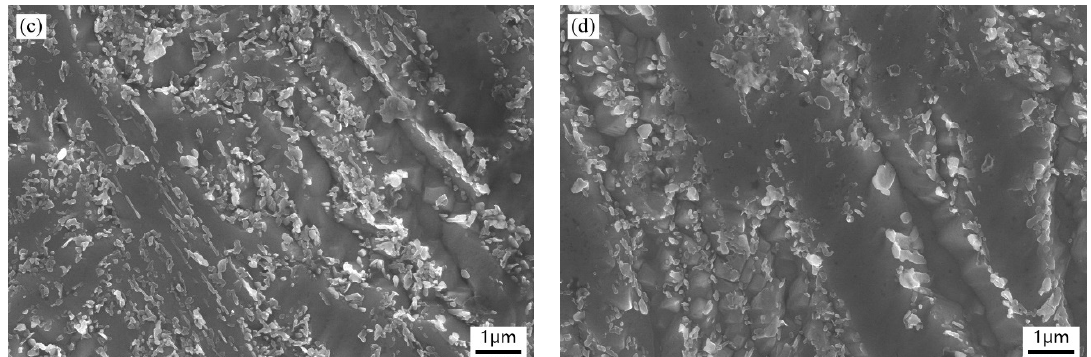
Figure 4. SEM images of the experimental steels after heat treatment ( a ) 1L (low Si and low temperature), ( b ) 1H (low Si and high temperature), ( c ) 2L (high Si and low temperature), and ( d ) 2H (high Si and high temperature).